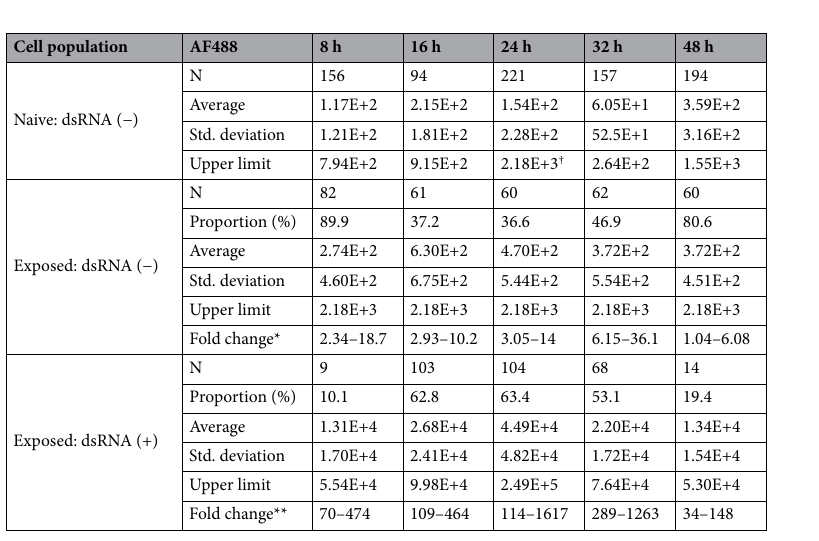
Table 1. Single cell measurements of dsRNA signal denoted by AF488 by each cell population. † Maximum single-cell measurement of AF488 in naïve population used to define the exposed dsRNA (+) population. *Signal difference between the exposed dsRNA (−) and Naive populations based on both the average and upper limit values. **Signal difference between the exposed dsRNA (+) and Naive population based on both the average and upper limit